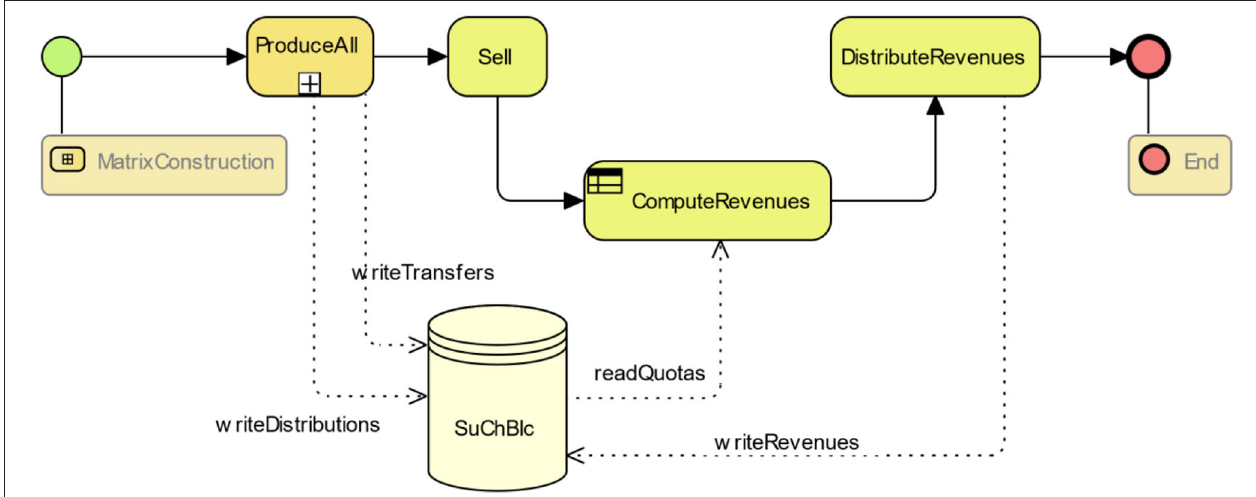
FIGURE 11 | The sub-process to distribute revenues after production and